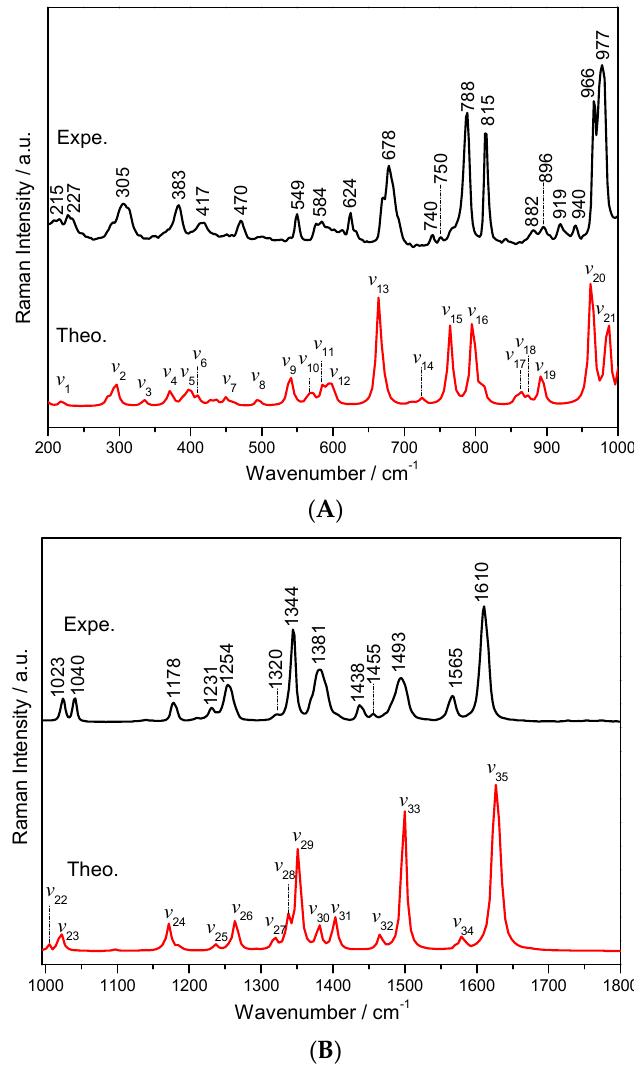
Figure 6. Comparison of the experimental (black line) and simulated (red line) Raman spectra of the NF–MELA-hydrated co-crystal ranging from 200 to 1000 cm − 1 ( A ) and 1000 to 1800 cm − 1 ( B ).